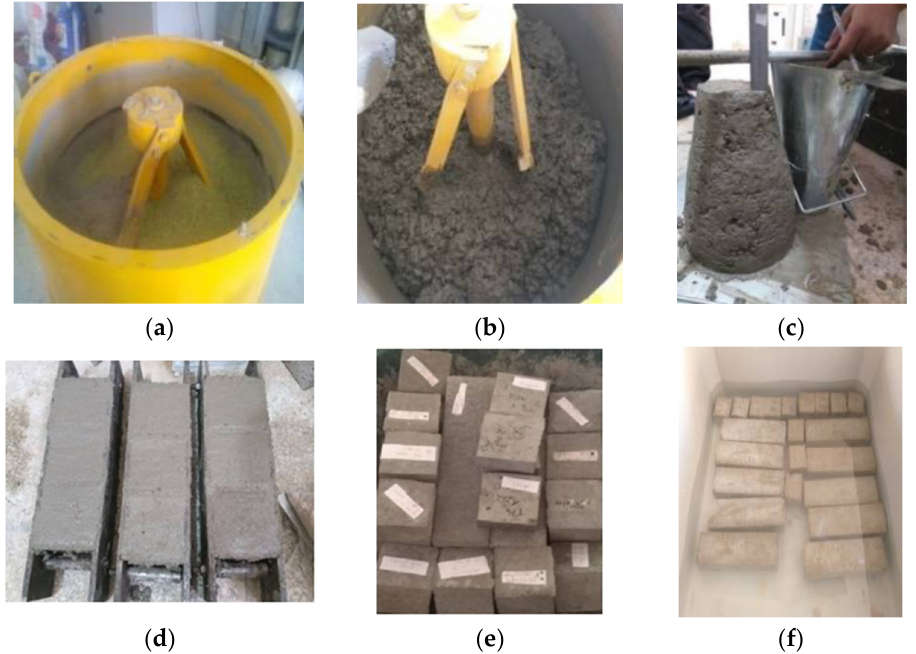
Figure 3. Preparation of specimen: ( a ) cement mixer machine, ( b ) mixing of concrete, ( c ) slump